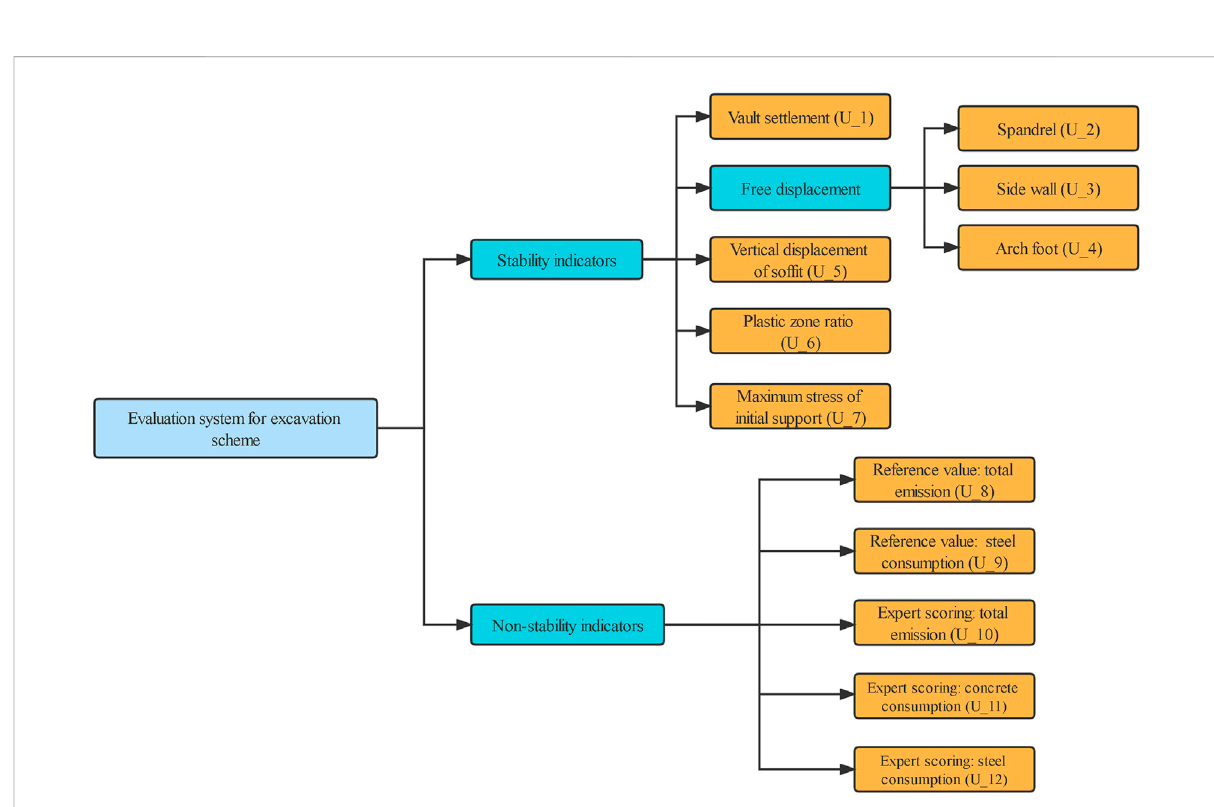
FIGURE 9 Evaluation index system used in this